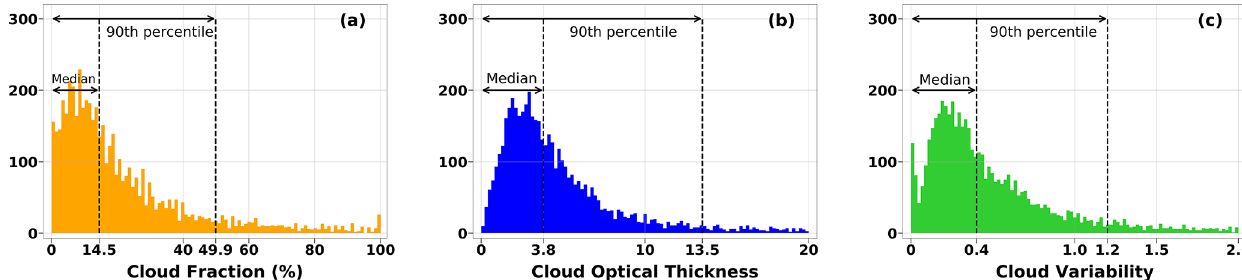
Figure 10. Histograms showing the distribution of the sampled data set used for training in terms of (a) cloud fraction, (b) cloud optical thickness, and (c) cloud variability. Despite being sampled using a gridding approach of Ref std vs. Ref mean , the balance is not necessarily reflected in these histograms. Particularly with the COT distribution seen in (b) , we see that the median COT is only 3.8%, and 90% of the samples have COT ≤ 13.5. The same imbalance is seen in (c) , with a median cloud variability of only 0.4, and 1.2 is the 90th percentile point.